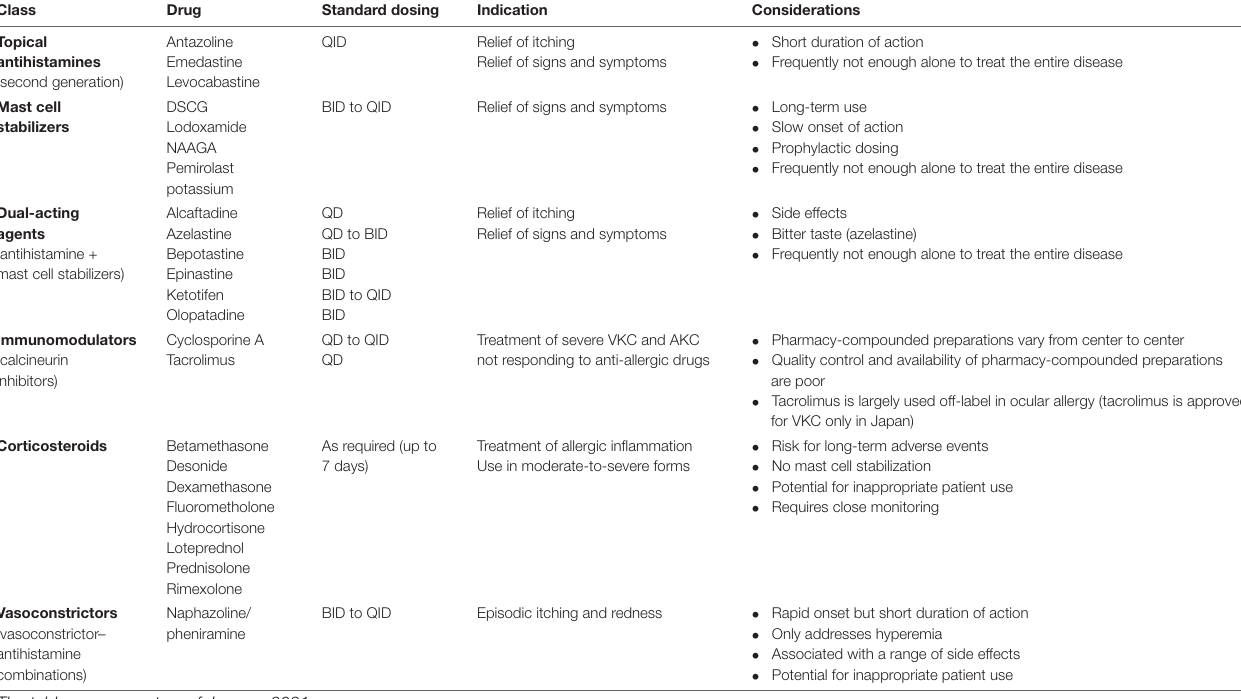
The table was correct as of January 2021. *Availability and access to treatments may vary across clinics, hospitals, regions, and countries. Each treatment option should be considered in accordance with the level of evidence available at the time. AKC, atopic keratoconjunctivitis; BID, twice daily; DSCG, disodium cromoglycate; NAAGA, N-acetyl-aspartyl glutamic acid; QD, once daily; QID, four times daily; VKC, vernal